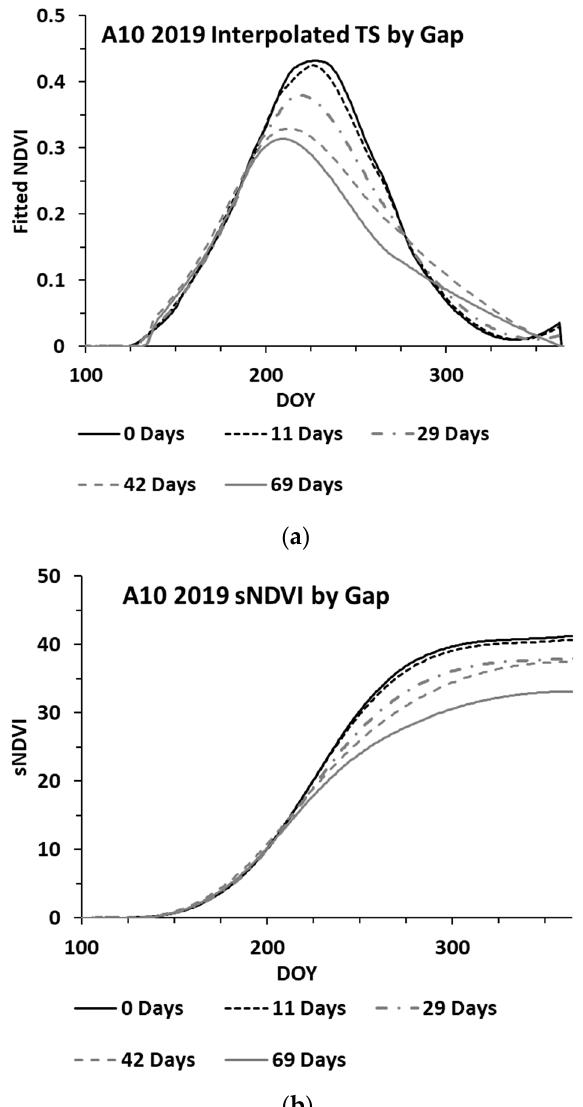
Figure 6. Mean of 100 time series (pixels), showing the effect of the increasing gap size on the ( a ) interpolated and ( b ) sNDVI time series.